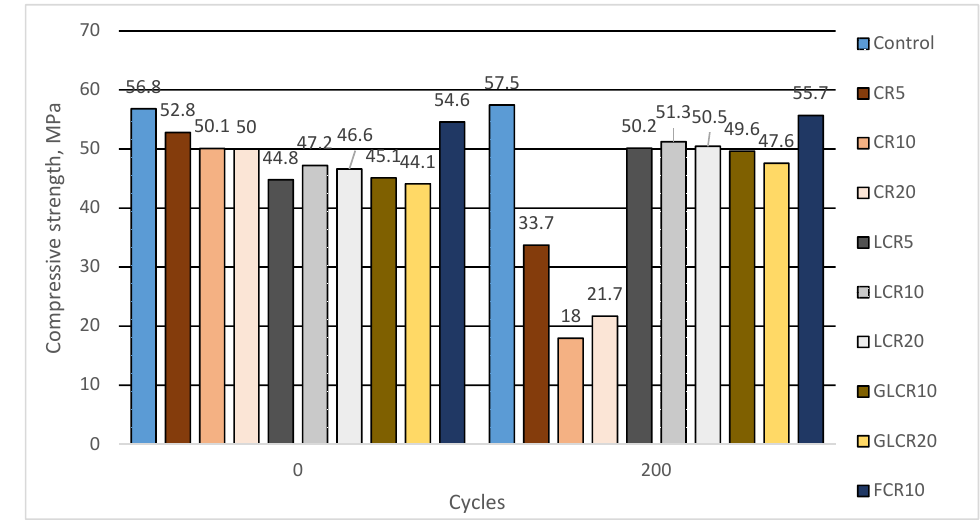
Cycles Figure 5. Changes in compressive strength of concrete in freeze-thaw resistance test. Porosity is the prime factor for concrete performance in a mechanical and durable environment. Concrete’s total porosity, open porosity, and close porosity are calculated by using a water absorption test. After 48 h of water absorption test, a control mix ab- sorbed 4.03% of water (Table 5). Untreated crumb rubber concretes absorbed little more water than a control mix. In that, CR10 concrete showed less water absorption than a con- trol, CR5, and CR20 concretes. The reason behind less water being absorbed by CR10 con- crete is that it consists of less open porosity and more close porosity than a control mix and the other two batches. The amount of water absorbed by CR5, CR10, and CR20 is about 4.11%, 3.72%, and 4.11%, respectively. In this literature [32], the water absorption rate is increased along with increased rubber content. After that the water absorption rate was slightly increased in SBR latex modified rubberized concretes and FCR10 due to more open porosity. The amount of water absorbed by LCR5, LCR10, LCR20 and FCR10 is about 4.46%, 4.47%, 4.48% and 4.35%, respectively.